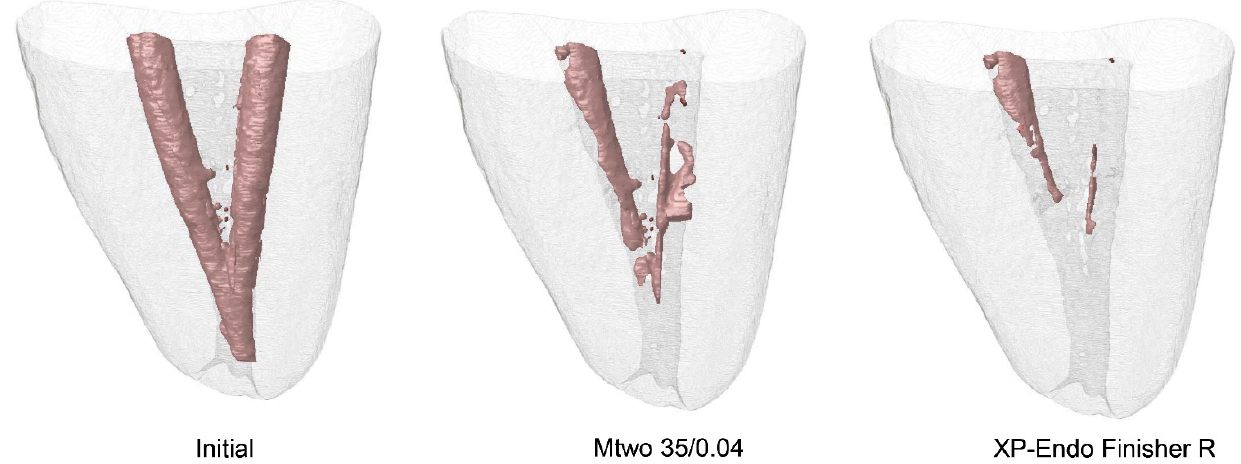
Figure 1. Microcomputed tomographic images of the apical segment of a mesial inferior molar root (class II of Vertucci, with isthmus) subjected to retreatment. Left , initial microtomographic scan performed after root canal obturation. Middle , post-preparation image obtained after retreatment with the Mtwo system (final instrument 35/0.04) in both canals. Right , final image after using the XP ‐ Endo Finisher R.